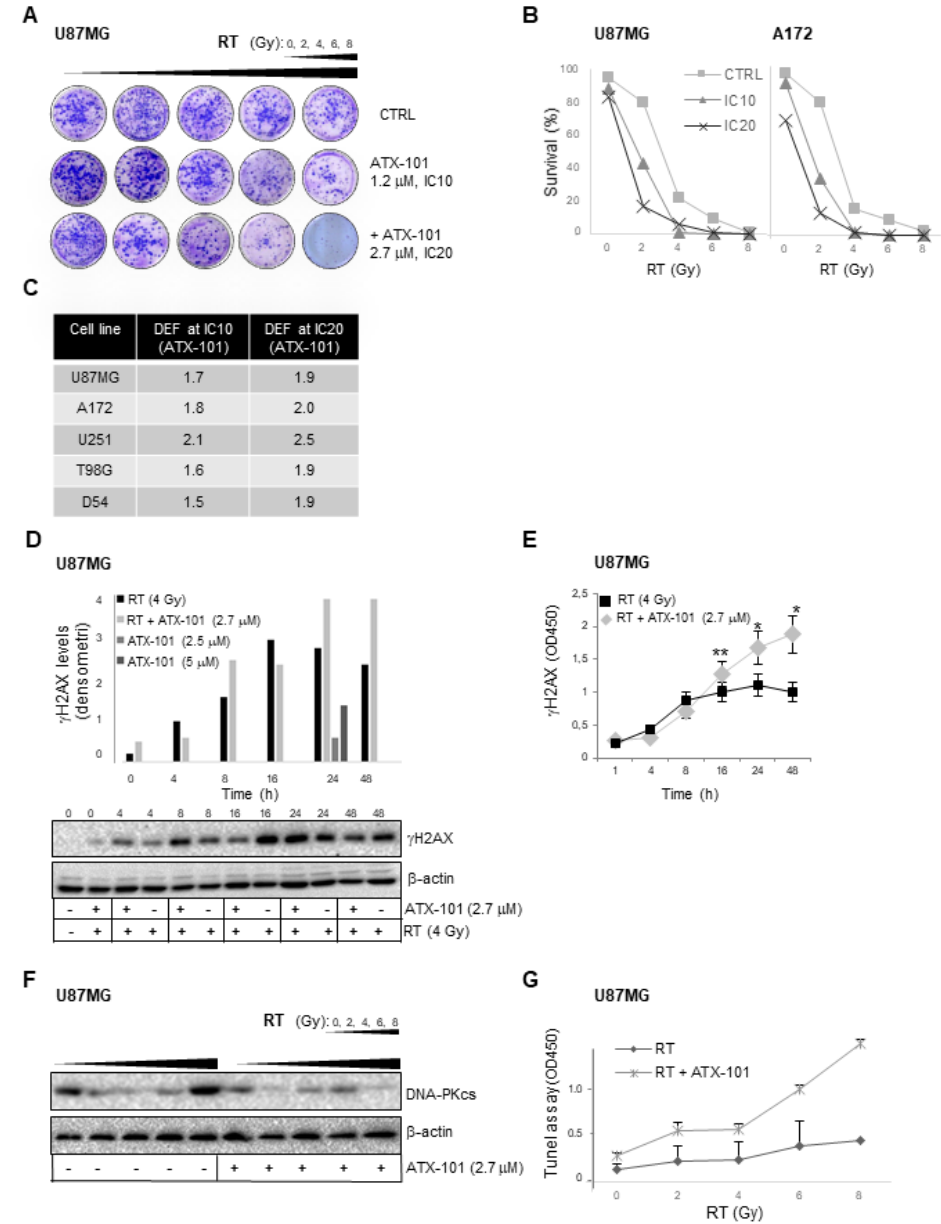
Figure 6. ATX-101 has radiosensitizing effects. ( A ) Representative images of crystal-violet-stained U87MG colonies (clonogenic assay) treated with ATX-101 IC10 (1.2 µ M) and IC20 (2.7 µ M) in combination with RT (2, 4, 6, and 8 Gy). ( B ) Surviving fractions of U87MG and A172 cells from clonogenic assays after treatment of cells with ATX-101 IC10 (1.2 µ M) and IC20 (2.7 µ M) in combination with RT (2, 4, 6, and 8 Gy). ( C ) Drug enhancement factor (DEF) for IC10 and IC20 doses of ATX-101 calculated in U87MG, A172, U251, T98G, and D54 cells. ( D ) Western blots showing γ H2AX levels in U87MG treated with RT (4 Gy) alone or in combination with ATX-101 IC20 (2.7 µ M) for 0–48 h (lower panel). Graphical presentation of densitometric values from the Western blots after normalization against β -actin (upper panel). Normalized values of γ H2AX in ATX-101 single treated U87MG cells (2.5 and 5 µ M) are shown for 24 h only. ( E ) γ H2AX levels determined by in-Cell ELISA (OD450) from U87MG treated with RT (4 Gy) alone or in combination with ATX-101 IC20 (2.7 µ M) for 24 h, ** p < 0.01, * p = 0.05. ( F ) Western blots showing the levels of activated DNA-PKcs in U87MG cells treated with ATX-101 IC20 (2.7 µ M) in combination with RT (2, 4, 6, and 8 Gy) for 24 h. Uncropped Western blots in ( D , F ) are shown in Supplementary Figure S6. ( G ) TUNEL assay in U87MG cells treated with ATX-101 IC20 (2.7 µ M) in combination with RT (2, 4, 6, and 8 Gy) for 24